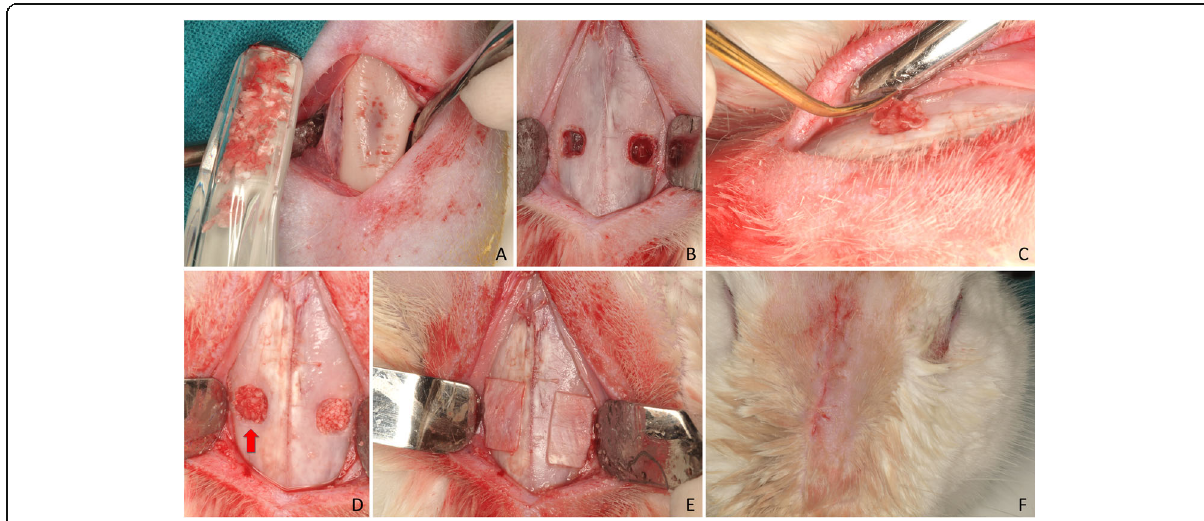
Fig. 1 Clinical view of the surgical procedures. a Tibial bone exposed for autogenous bone harvesting using a bone scraper. b